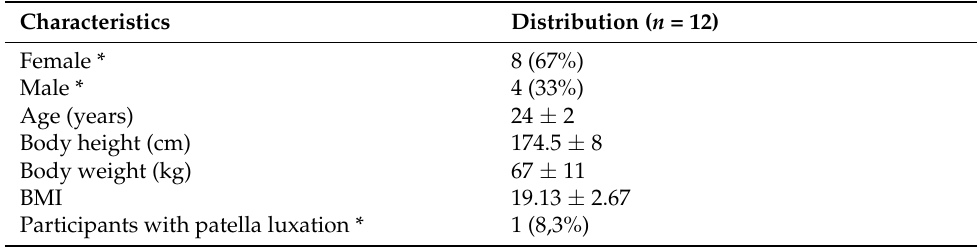
Table 1. Demographic and clinical characteristics of the study